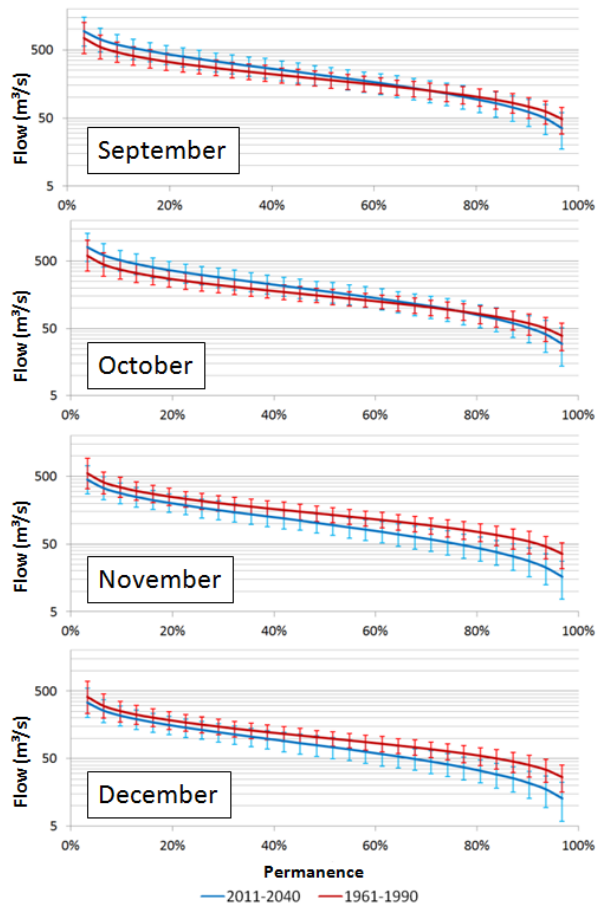
Figure 10. Mean and 90% confidence interval for the monthly flow permanence curves at Santo Ângelo gauge station, according to the stochastic series generated in the base period (1961–1990) and fu- ture period (2011–2040): May, June, July and August.